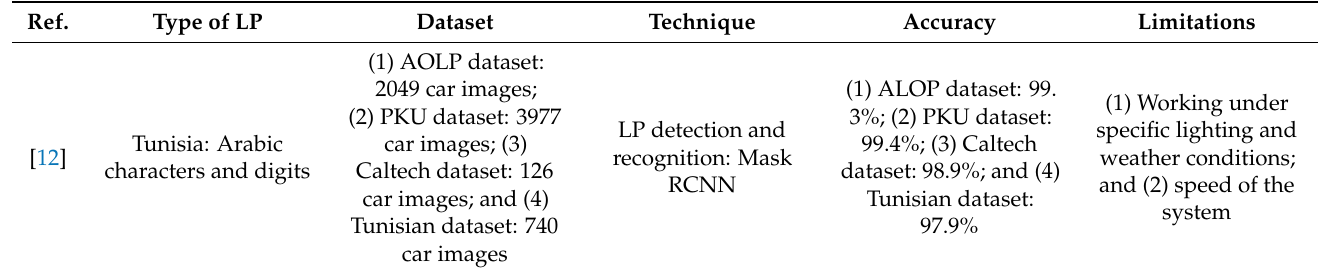
Table 1. Comparison of DL-based approaches for LP